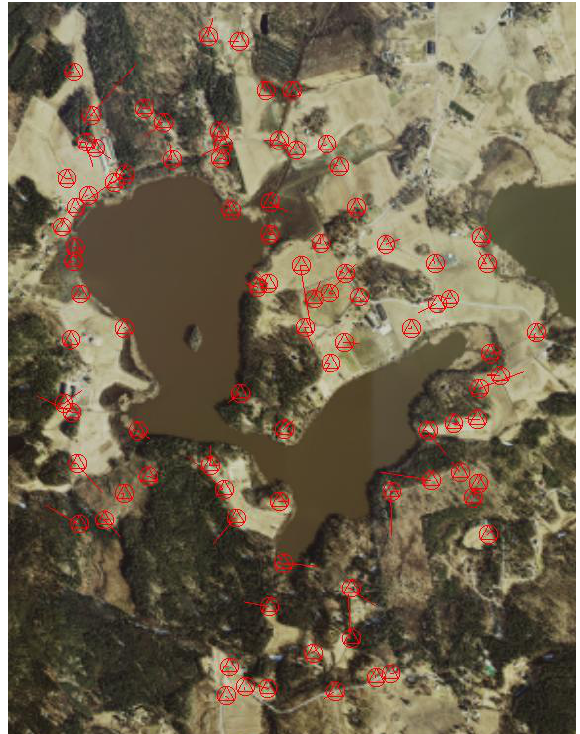
Figure 2. The test area. 3D XYZ ground control points were taken from the national open digital orthoimages and digital height model. © The National Land Survey of Finland. Colour orthophoto Elevation model 10